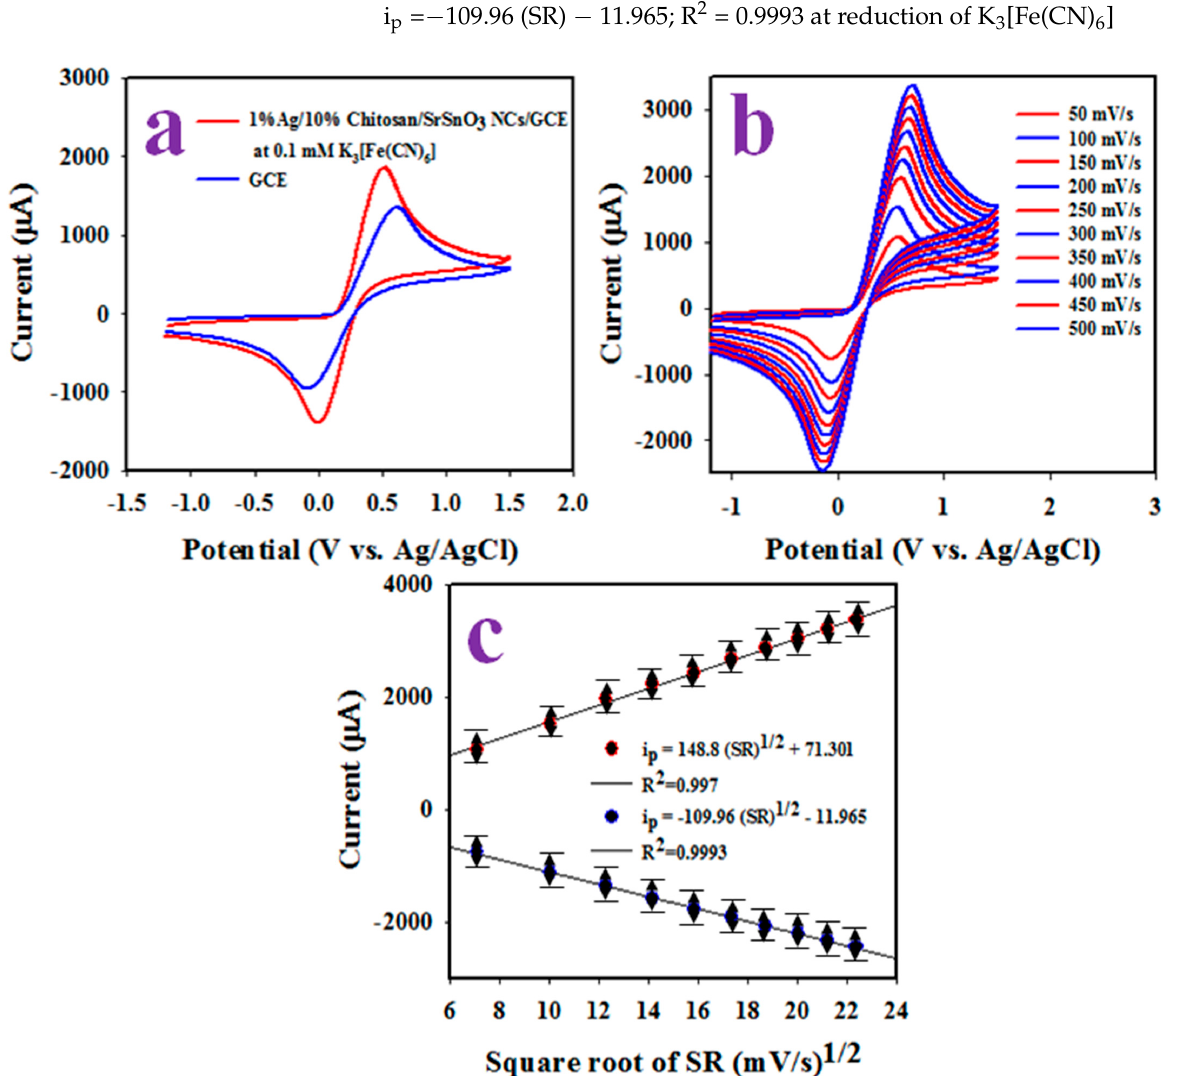
Figure 7. Electrochemical characterization of Ag-decorated Chitosan/SrSnO 3 NC/GCE by cyclic voltammetry. ( a ) Comparison of coated and bare GCE in analysis of 0.1 mM K 4 [Fe(CN) 6 ], ( b ) Scan rate at 50~300 mV/s, and ( c ) Current versus square root of SR.